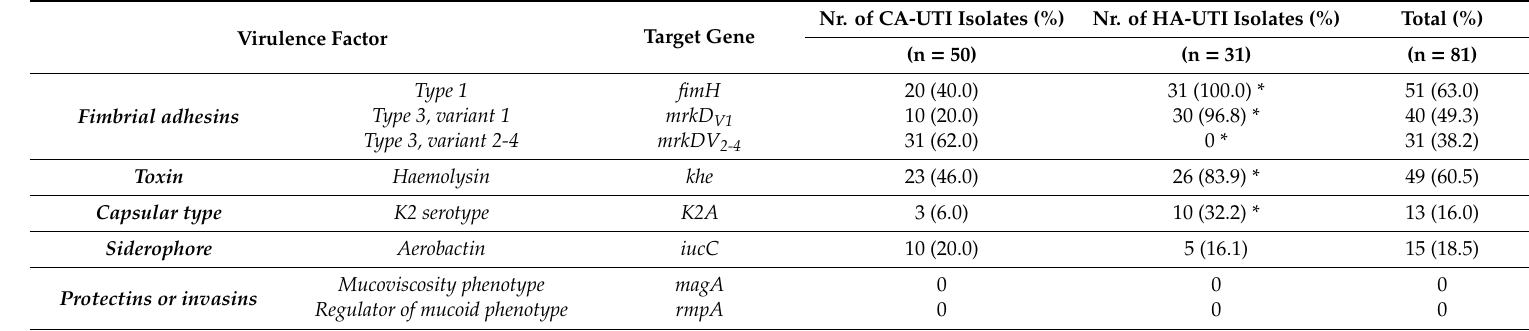
Table 2. Distribution of virulence genes in K. pneumoniae isolates from community-acquired urinary tract infections (CA-UTI) and hospital-acquired urinary tract infections